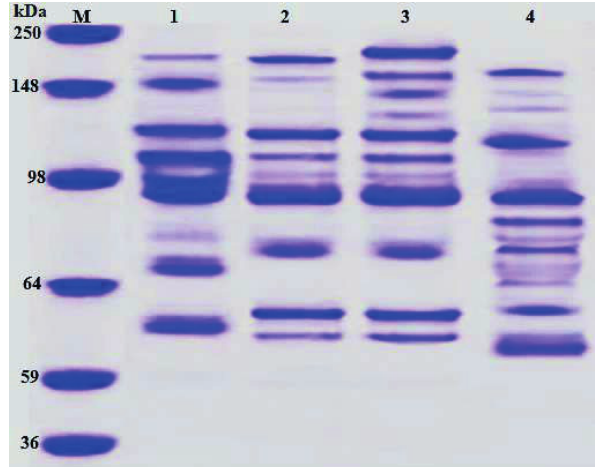
Figure 1. Polypeptide banding patterns analyzed by Sodium dodecyl sulfate-polyacrylamide gel electrophoresis (SDS-PAGE) technique of non-exposed and EMR exposed seedlings of Zea mays for days of exposure times (Ex-0, Ex-1, Ex-3,and Ex-5) based on relative front (R f ) Values and optical densities (OD). Lanes 1–4 represented the days of exposure times (Ex-0, Ex-1, Ex- 3,and Ex-5),